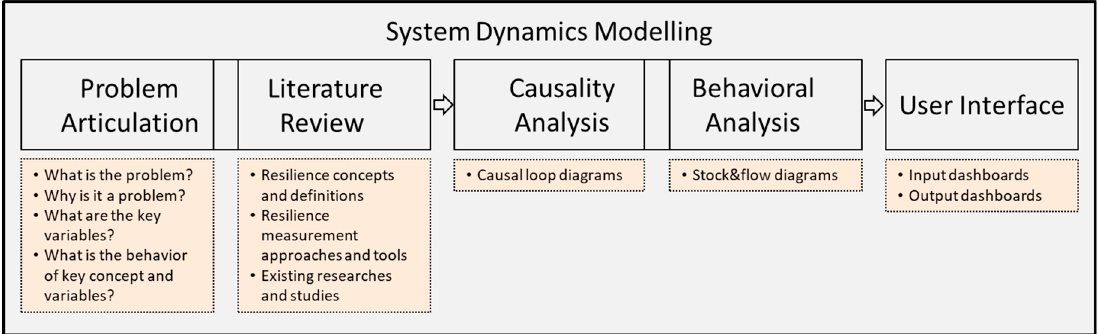
Figure 1. Methodology of the study.